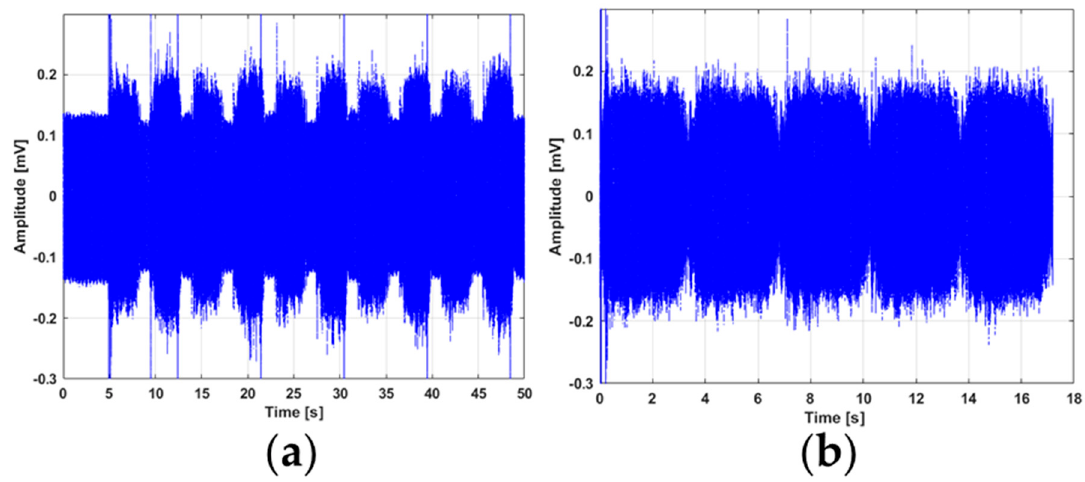
Figure 4. AE signal recorded from the experimental test rig, from the test at 100 bar and 50 mm/s rod: ( a ) original data; ( b ) pre-processed data (extraction stroke only).